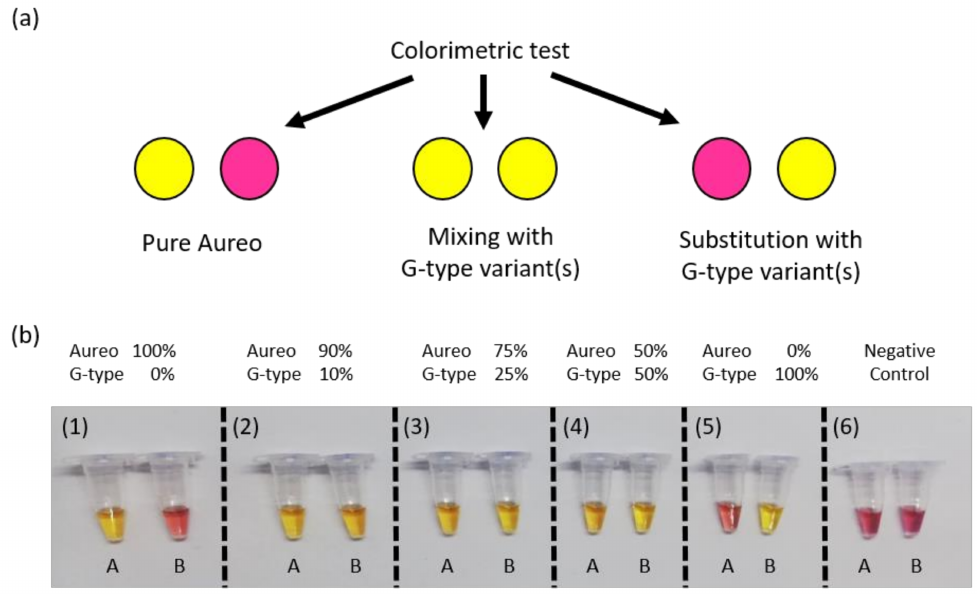
Figure 5. ( a ) Schematic of the colorimetric test displaying the possible yellow / purple color combinations: pure Aureo variety (yellow / purple), adulterated mixture with G-type varieties (yellow / yellow), or fully substituted product (purple / yellow). ( b ) Colorimetric detection of possible adulteration cases of Aureo with a G-type wheat variant (here, Babylon is used as an example). LAMP reactions with loop primer T (tube A) and loop primer G (tube B) were all performed at 63 ◦ C for 1 h. From left to right, targets were composed of 100% of the Aureo variant of wheat (sample 1), then mixtures of Aureo and G-type variant (from 10 to 100%, samples 2–5), and a negative control (sample 6).